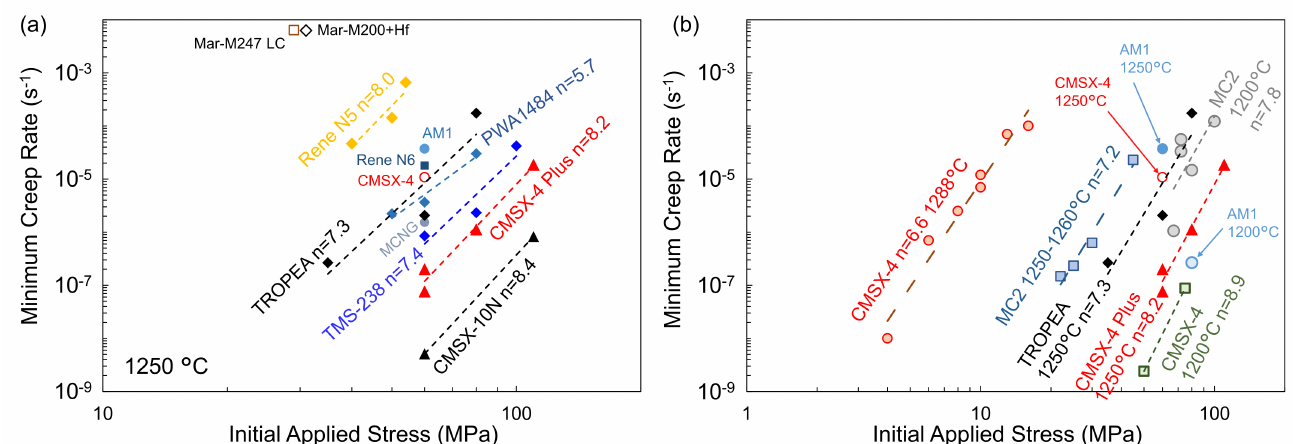
Figure 6. Minimum creep strain rate as a function of the initial applied stress for Ni-based SX superalloys tested in this study ( a ) and with data from references ( b ). CMSX-4 at 1288 ◦ C [17], MC2 at 1200 ◦ C [34], CMSX-4 at 1200 ◦ C [4], AM1 at 1200 ◦ C [16]. MC2 at 1250-1260 ◦ C is from internal database in Institut Pprime tested using the MAATRE burner rig